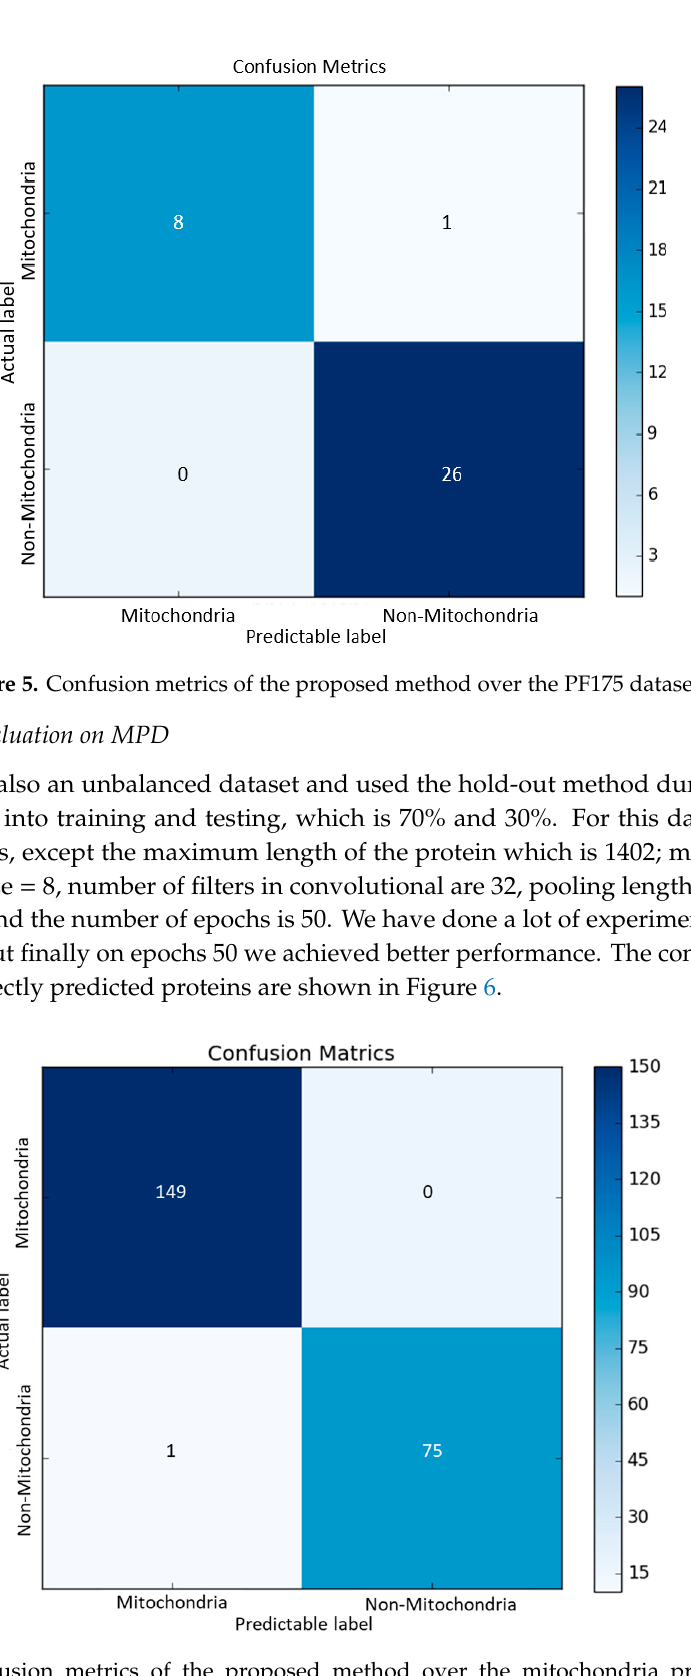
Figure 6. Confusion metrics of the proposed method over the mitochondria protein dataset (MPD)